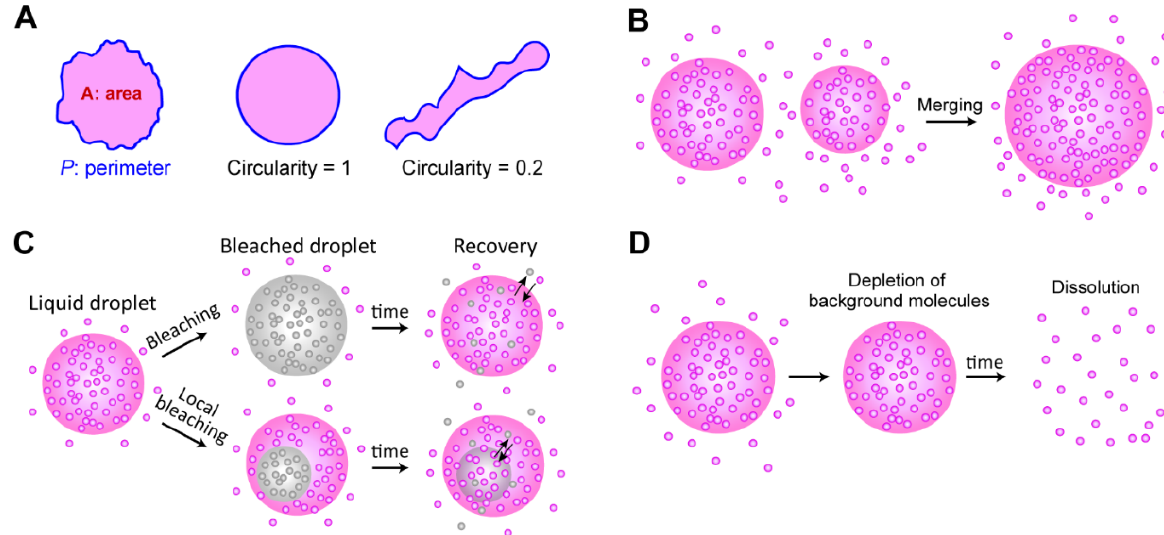
Figure 4. Criteria for liquidity. ( A ) The spherical shape of a liquid droplet. To quantify how much the droplet is close to a spherical shape, circularity is calculated by measuring the area (magenta regions) and the perimeter of a droplet (blue boundaries). The circularity is defined by 4 π A / P 2 and it ranges from 0 (very different from a circular shape) to 1 (a circular shape). ( B ) Merging of two distinct droplets. ( C ) FRAP experiment showing exchangeability of molecules between background solution and a droplet (top) and diffusability in a single droplet (bottom). ( D ) Reversibility test. If background proteins are depleted, a liquid droplet is dissolved into a solute phase.